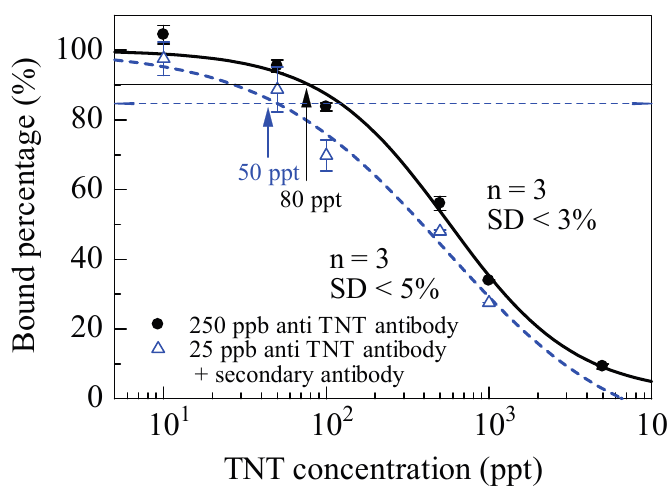
Figure 4. Response curves for TNT